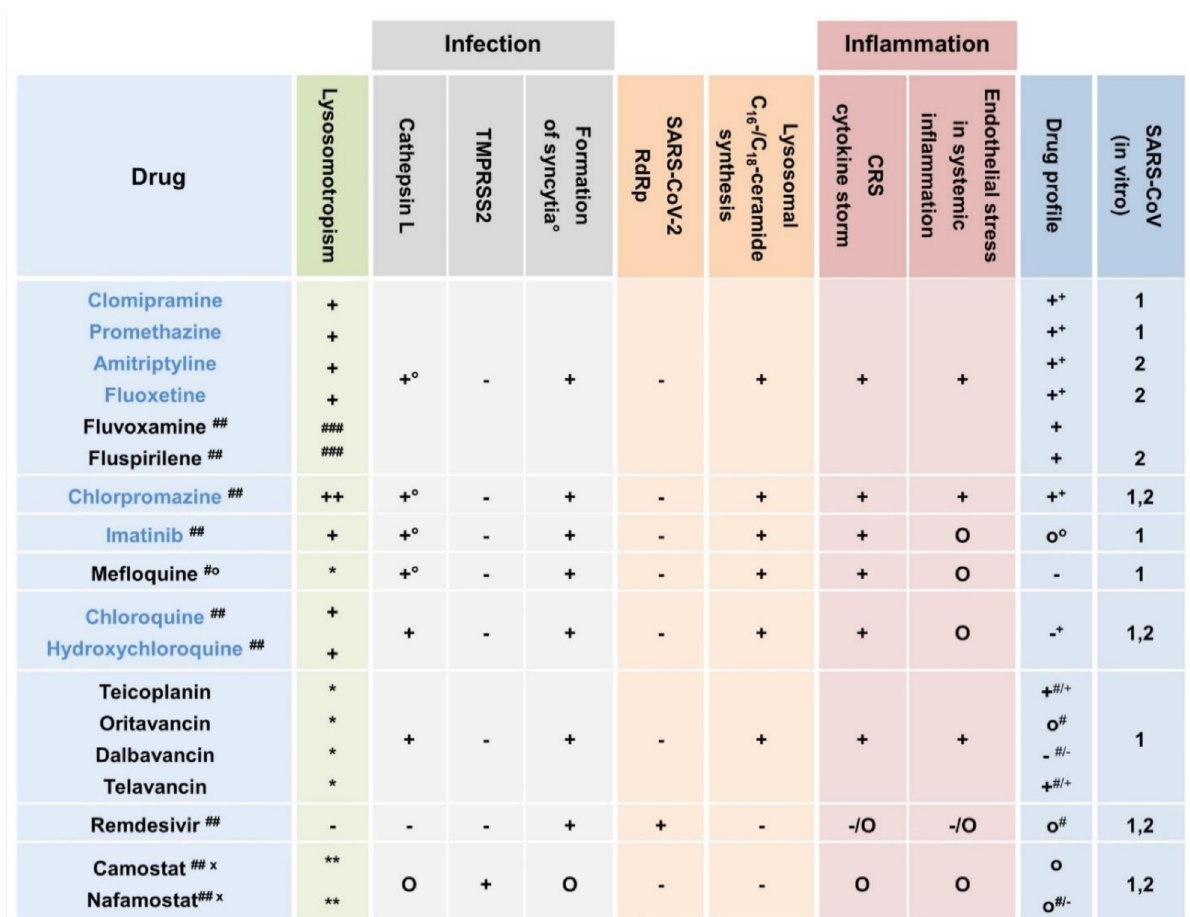
Figure 1. Variety of approved compounds for targets in SARS-CoV-2 infection/Coronavirus disease 2019 (COVID-19). Lysosomotropism: achievement of the desired lysosomotropic effect depended on the drug, the dosage, and accumulation in pulmonary tissue and in lysosomes. Unless indicated, maximum daily doses are typically split into three applications according to the patient information leaflet/market authorization. Confirmed lysosomotropism (blue colored): lysosomal drug concentration (effect) within the therapeutic margin in vivo (expected): (++) occurs at maximum daily dosage and very likely in low or initial dosage, (+) very likely at maximum daily dosage and possible in low or initial dosage. Supposed lysosomotropism: (*) lysosomotropism very likely but not yet confirmed, lysosomal drug concentration (effect) within the therapeutic margin expected; (**) lysosomotropism likely but not yet confirmed, lysosomal drug concentration (effect) within the therapeutic margin not expected; ( ### ) lysosomotropism very likely but not yet confirmed, no lysosomal drug concentration (effect) within the therapeutic margin expected. Efficacy on targets cathepsin L, TMPRSS2, formation of syncytia, SARS-CoV-2 RdRp, lysosomal C 16 -/C 18 -ceramide synthesis, endothelial stress in systemic inflammation, and CRS/cytokine storm [8,10–12,22,25–29]: (+ ◦ ) proven in vitro; (+) is very likely; (O) is (mediated) possible; (-) no effect. Drug profile: (+) good; (o) moderate; (-) worse, assessment depending on elimination half-life and severe adverse effects; accumulation in pulmonary tissue: ( + ) proven, ( o ) likely, ( - ) no accumulation in pulmonary tissue; ( # ) only intravenous application; ( ## ) in COVID-19 clinical trials; ( #o ) dosage depending on treatment or prophylaxis (of malaria); * inhibits serine proteases related to coagulation and fibrinolysis, and prevents (sepsis-related) disseminated intravascular coagulation and thrombotic microangiopathy; ( x ) sufficient TMPRSS2 inhibiting concentration questionable in pulmonary tissue within the therapeutic